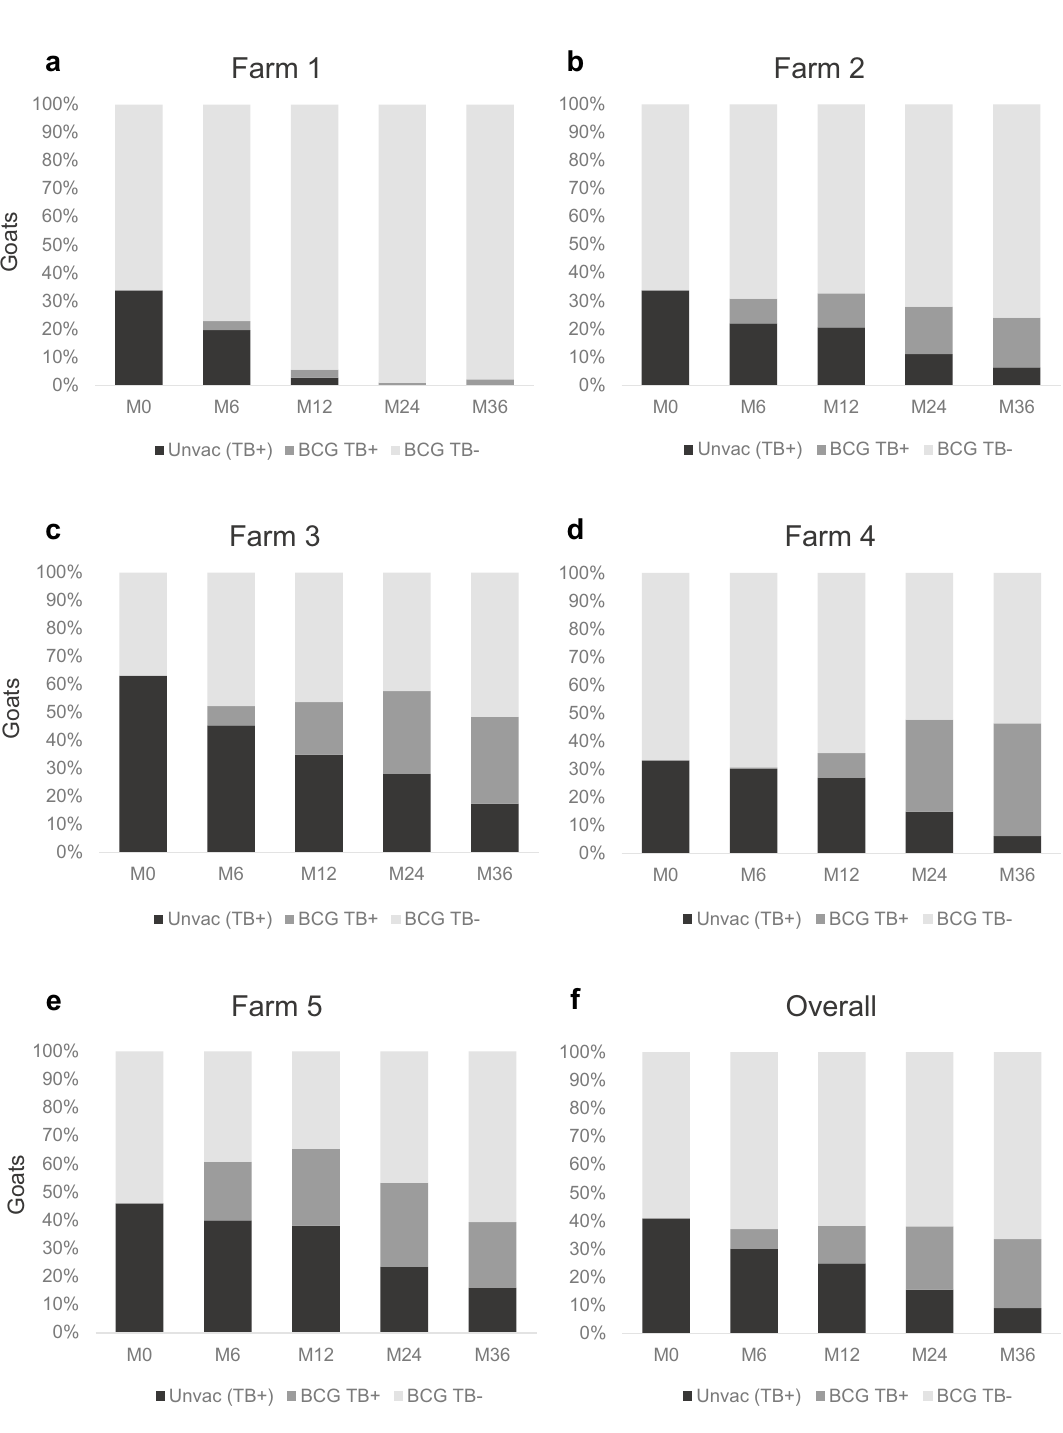
Figure 2. Proportion of TB positive and BCG vaccinated goats from farms 1 ( a ), 2 ( b ), 3 ( c ), 4 ( d ), 5 ( e ) and all farms ( f ) throughout the trial. Evolution of population of vaccinated goats TB negative (light grey), vaccinated TB positive goats (dark grey) and unvaccinated animals (black) during the 36 months (M) of